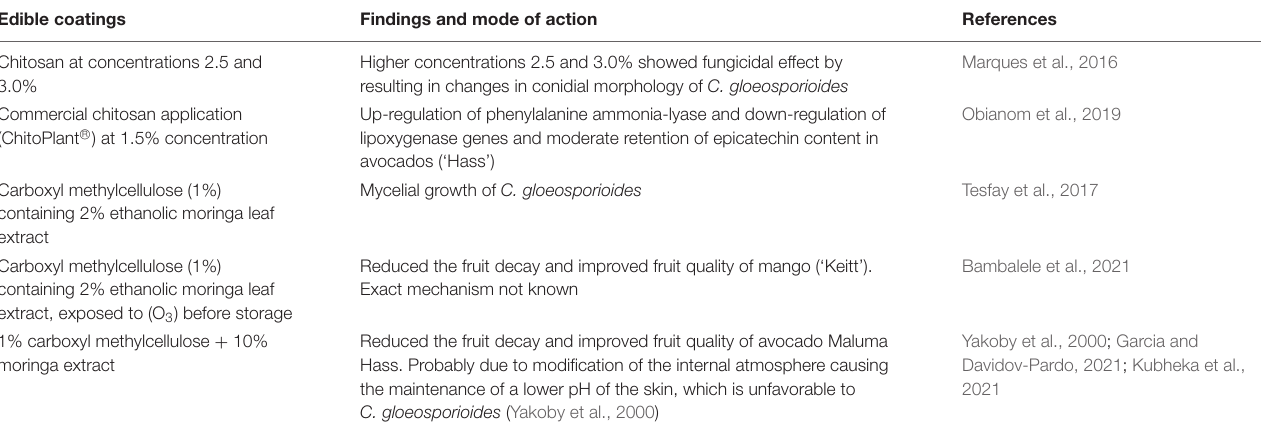
TABLE 1 | Recent advances on edible coating and additives applied for subtropical fruits avocado and mangoes. Edible coatings Findings and mode of action Chitosan at concentrations 2.5 and